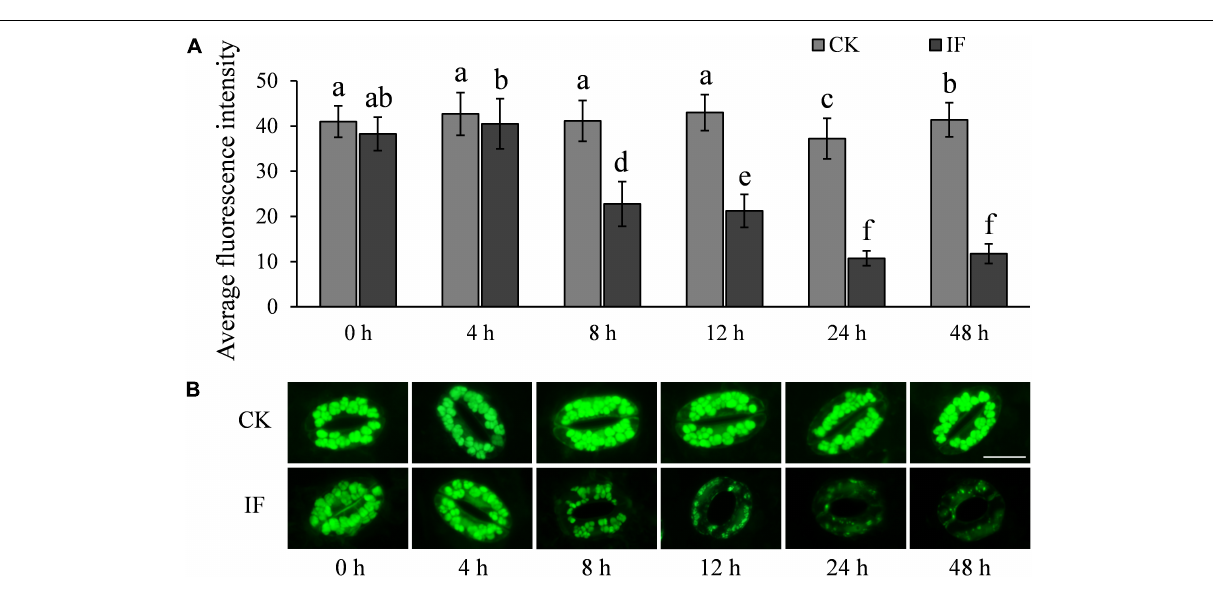
FIGURE 8 | NO accumulation changes in potato guard cells during P. infestans infection: (A) NO dynamics in the P. infestans -infected (IF) and non-infected (CK) potato guard cells; and (B) images showing the fluorescence intensity of DAF-FM DA in IF and CK potato guard cells. The marker = 20 µ m. Photos within a panel are from a representative of a single replicate while photos among panels are pooled from multiple